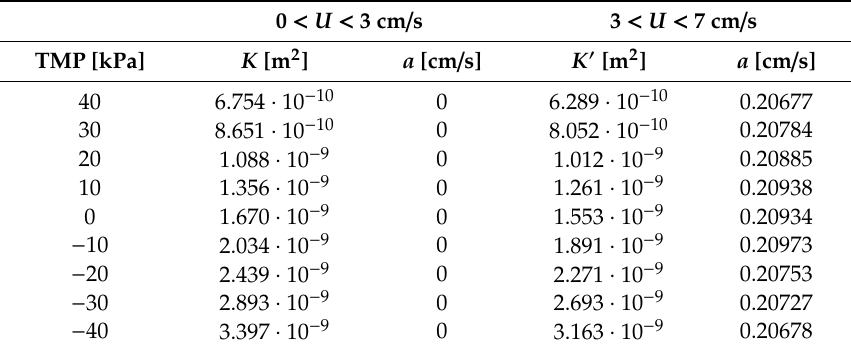
Table A2. Slopes and intercepts for superficial velocity ranging between 0 and 7 cm / s.